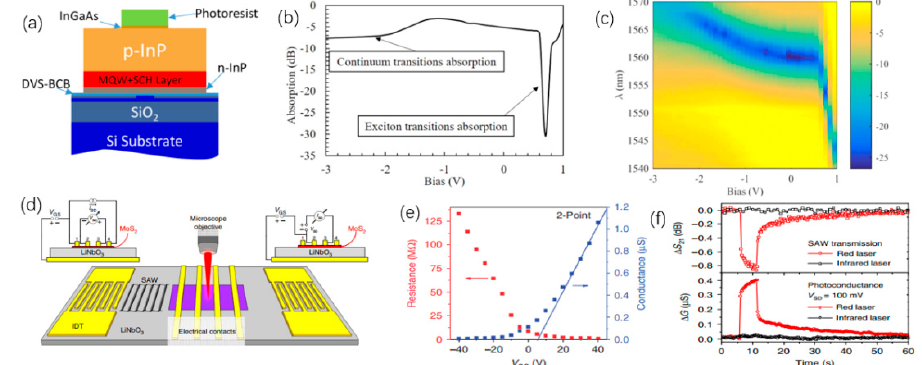
Figure 18. ( a ) Structure diagram of absorption modulator with indium phosphide. ( b ) The absorption curve of the modulator when the bias voltage changes. ( c ) The spectrum of the modulator when the bias voltage changes [295]. Copyright 2016 AIP Publishing LLC. ( d ) Experimental diagram of MoS 2 /LiNbO 3 acousto-electric device. ( e ) Resistance and conductance change curve with VGS. ( f ) The response time of MoS 2 /LiNbO 3 under two measurement methods [292]. Copyright 2015 American Publishers Limited.